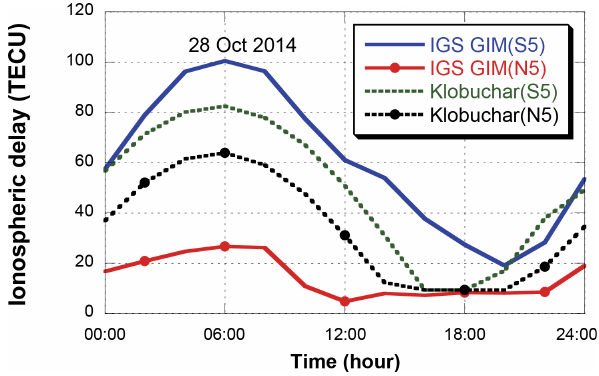
Figure 9. Extrapolation errors for each direction (5 ◦ extrapolation regions).